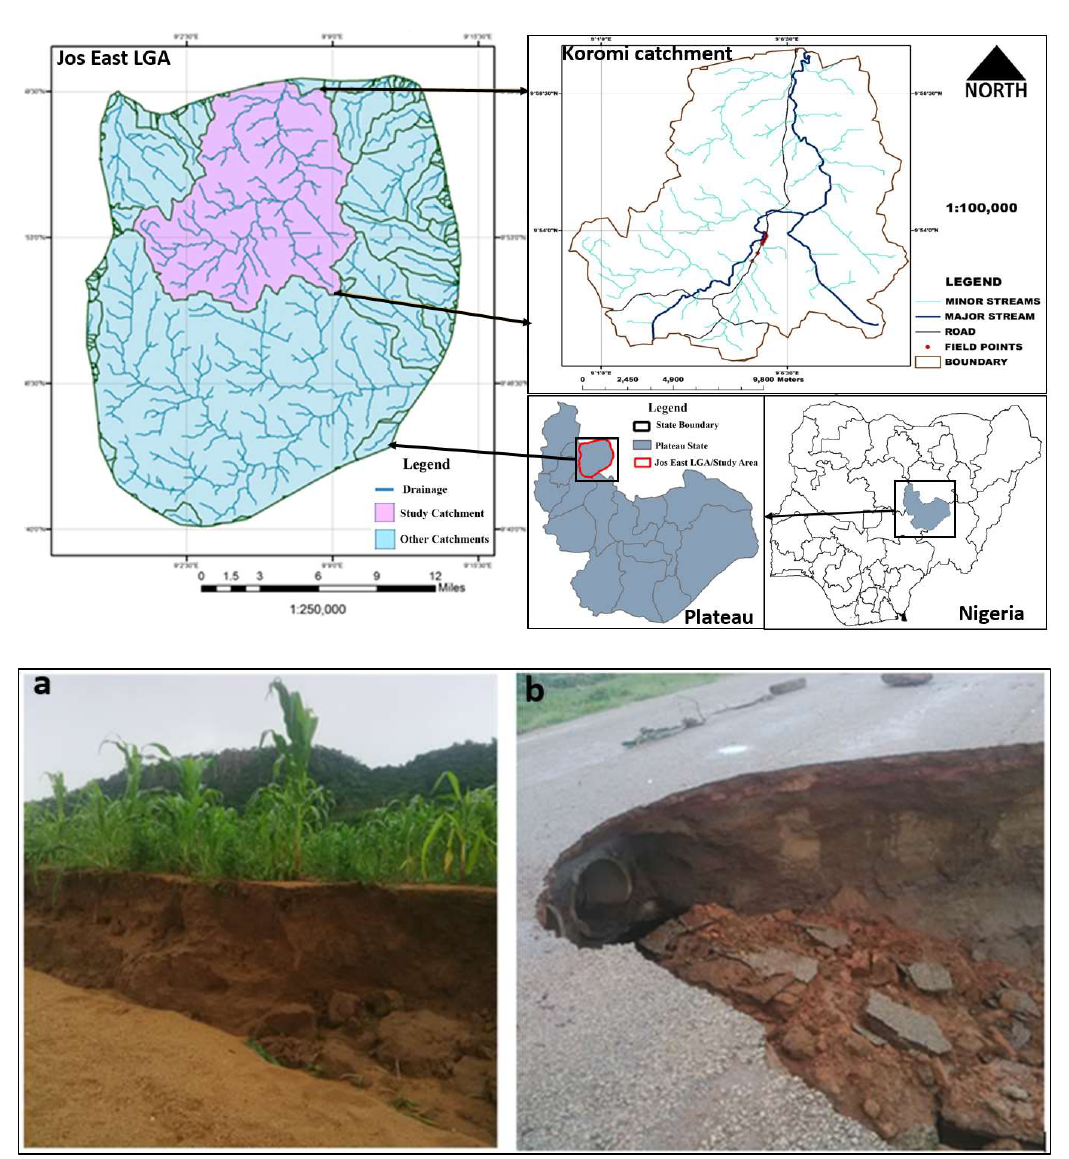
Figure 1. Map of Jos East LGA showing the location of Koromi catchment and drainages. ( a ). is a cultivated field in the Koromi catchment partially eroded; ( b ). is the main Fobur to Ferere road eroded. Both pictures were captured in 2015 during the field work exercise.